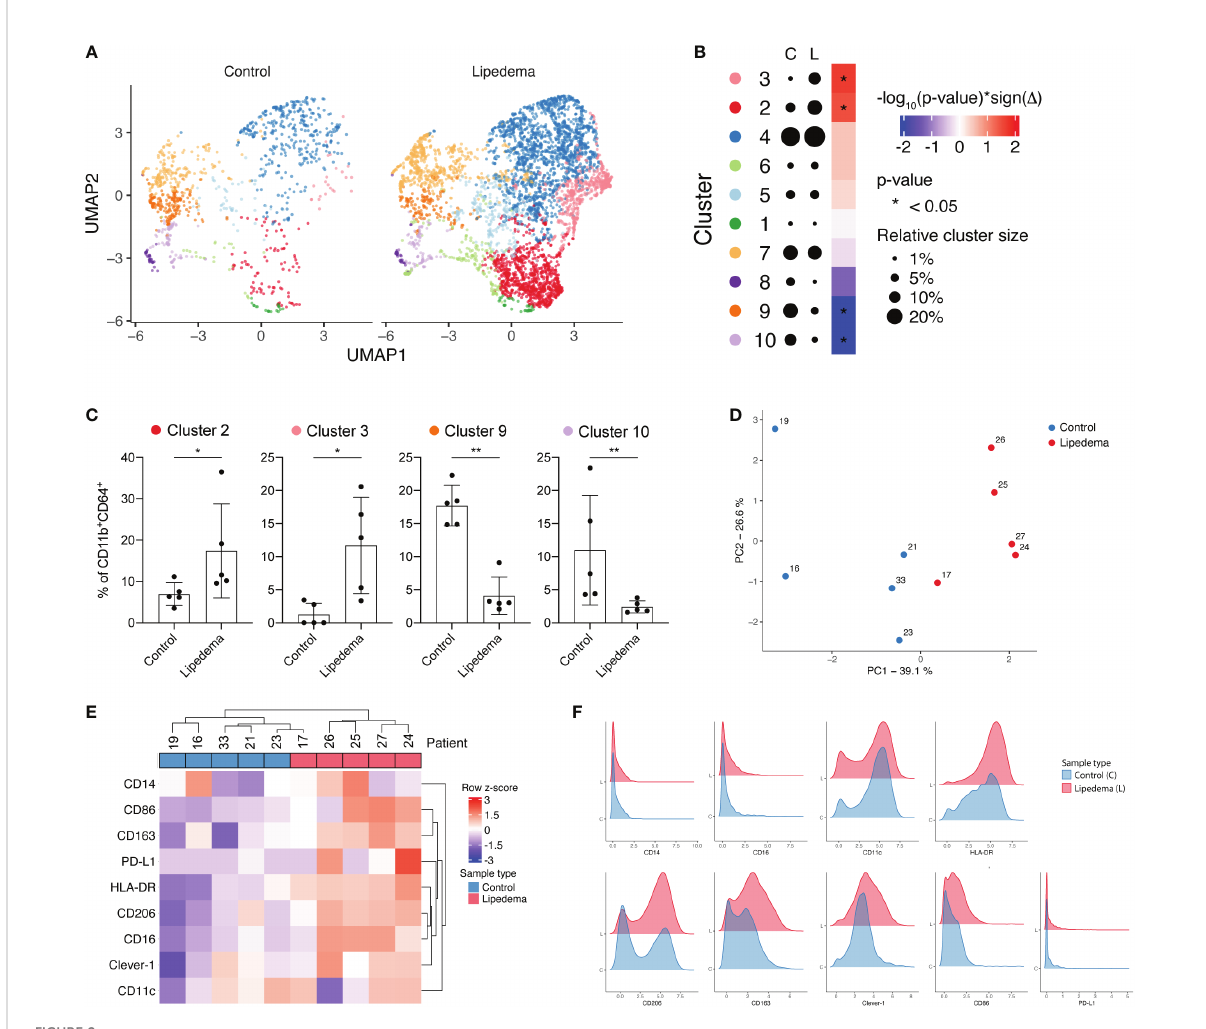
FIGURE 2 Lipedema patients show higher proportions of immunosuppressive CD206 + CD163 + Clever-1 + macrophages. (A) FlowSOM metaclusters of CD11b + CD64 + cells displayed on separate UMAP plots of healthy controls (n = 5, 1066 cells) and lipedema patients (n = 5, 4642 cells). (B) A dot plot of average FlowSOM metacluster sizes in healthy control and lipedema patient groups. Dot radiuses represent average percentage of cells belonging to each metacluster. Heatmap displays statistical signi fi cances (Mann-Whitney U test) with red colour indicating increase and blue colour decrease in comparison to the control group. (C) FlowSOM metaclusters that were signi fi cantly more or less abundant in lipedema patients. Each dot represents metacluster relative size in a healthy control or a lipedema patient. Mann-Whitney U test. * P < 0.05; ** P < 0.01 (D) Principal component analysis based on relative FlowSOM metacluster sizes in each individual. (E) Unsupervised hierarchical clustering of control and lipedema samples based on median marker expression levels on CD11b + CD64 + cells. (F) Density plots showing the expression of indicated markers on CD11b + CD64 + cells in control and lipedema